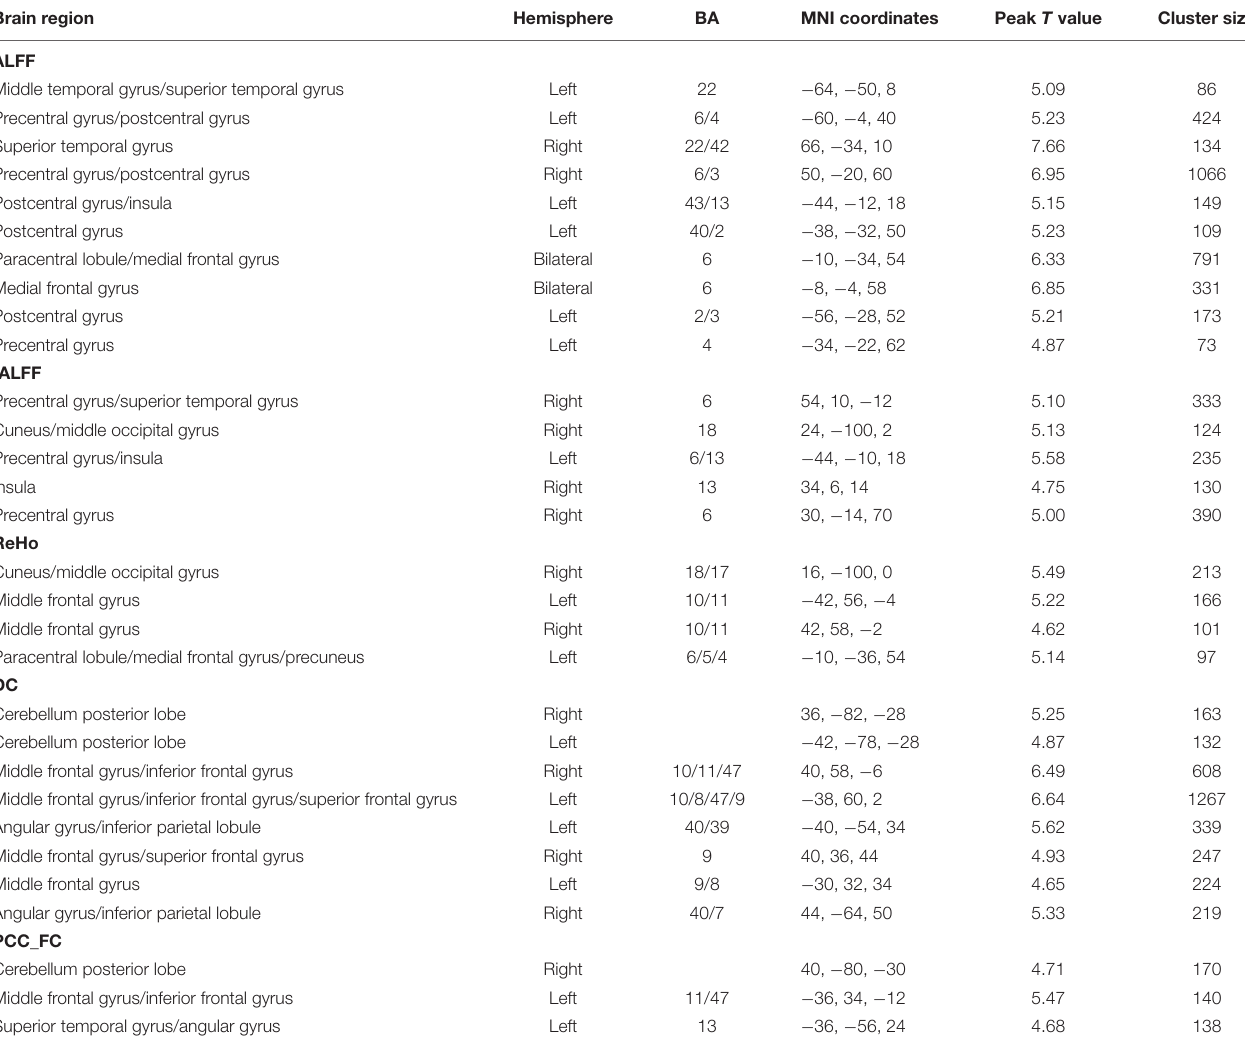
TABLE 2 | Regions showing significant gender differences (male > female) for each index. Brain region Hemisphere BA MNI coordinates Peak T value